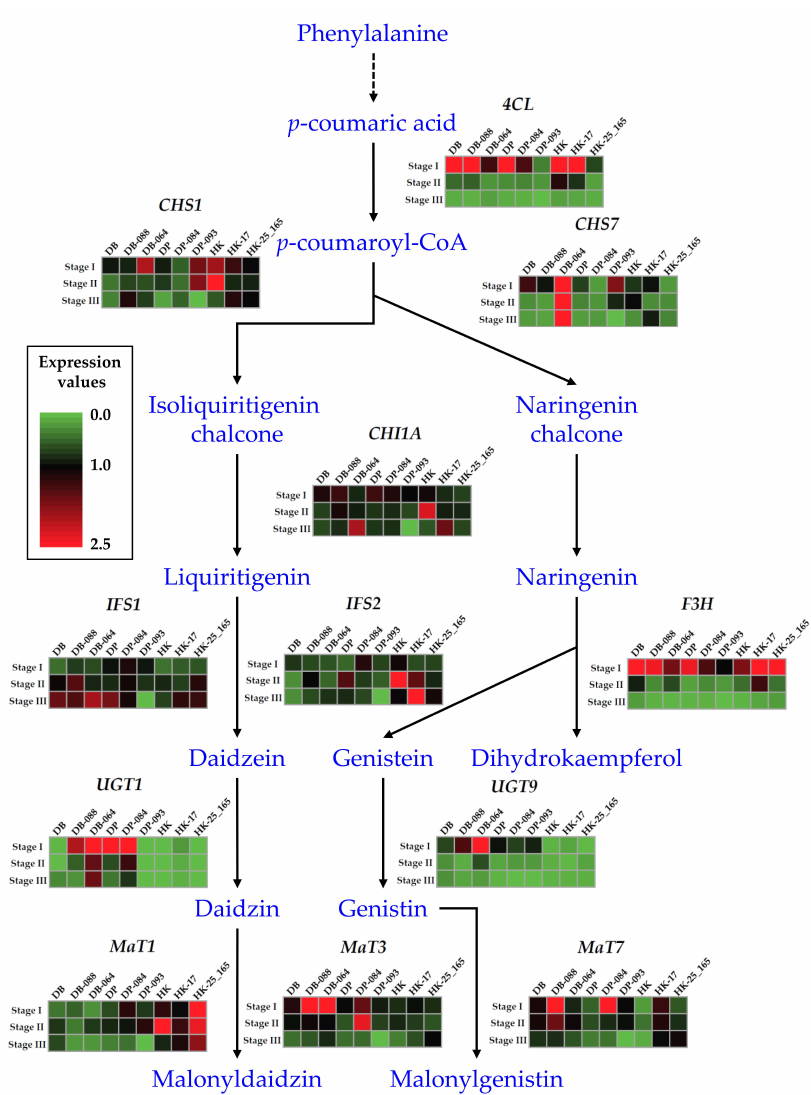
Figure 4. Transcript levels of the 12 major structural genes in the isoflavone biosynthetic pathway. For each gene, the transcript level for six selected mutant lines and three wild-type cultivars analyzed in this study are displayed as a heatmap based on the normalized C t